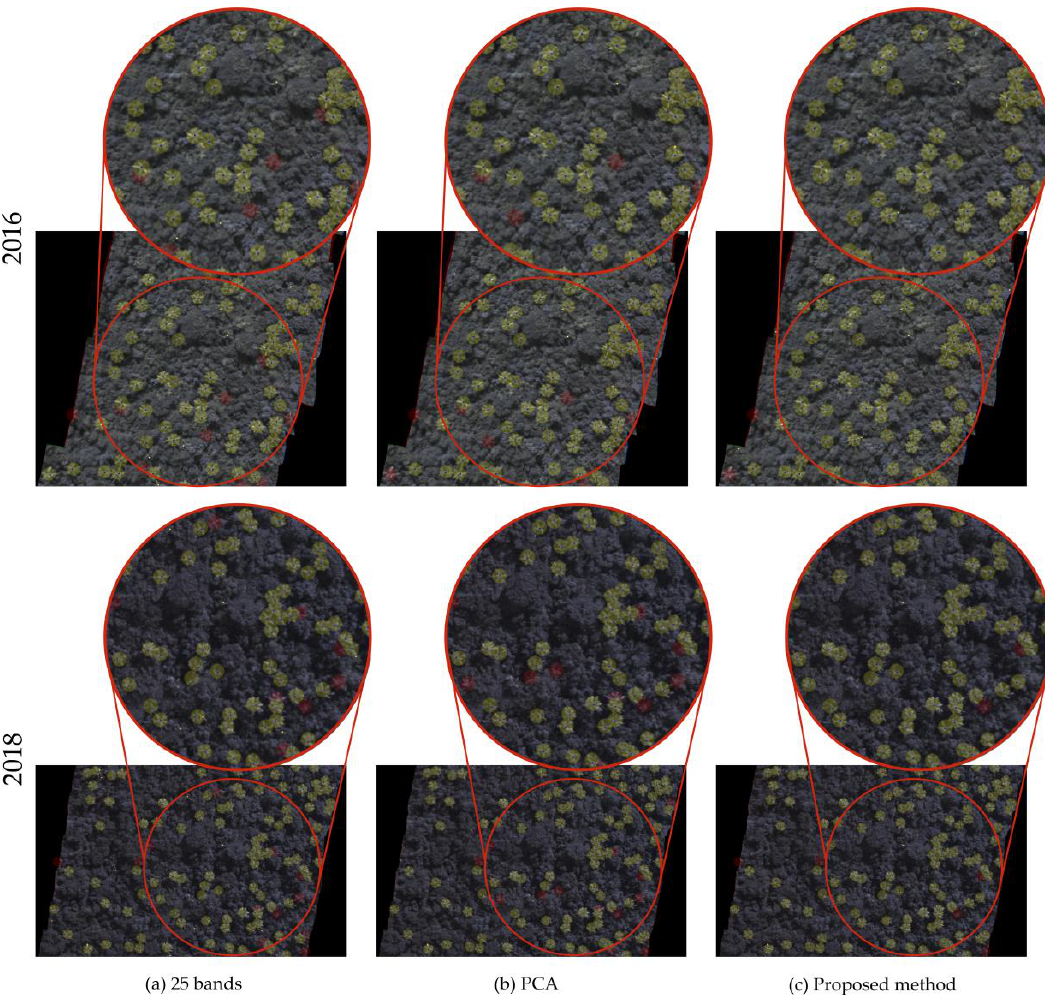
Figure 9. Qualitative results of the tree detection using ( a ) all 25 bands, ( b ) PCA, and the ( c ) proposed method for the 2016 and 2018 images. The yellowish trees were correctly detected, while the redder ones were undetected.